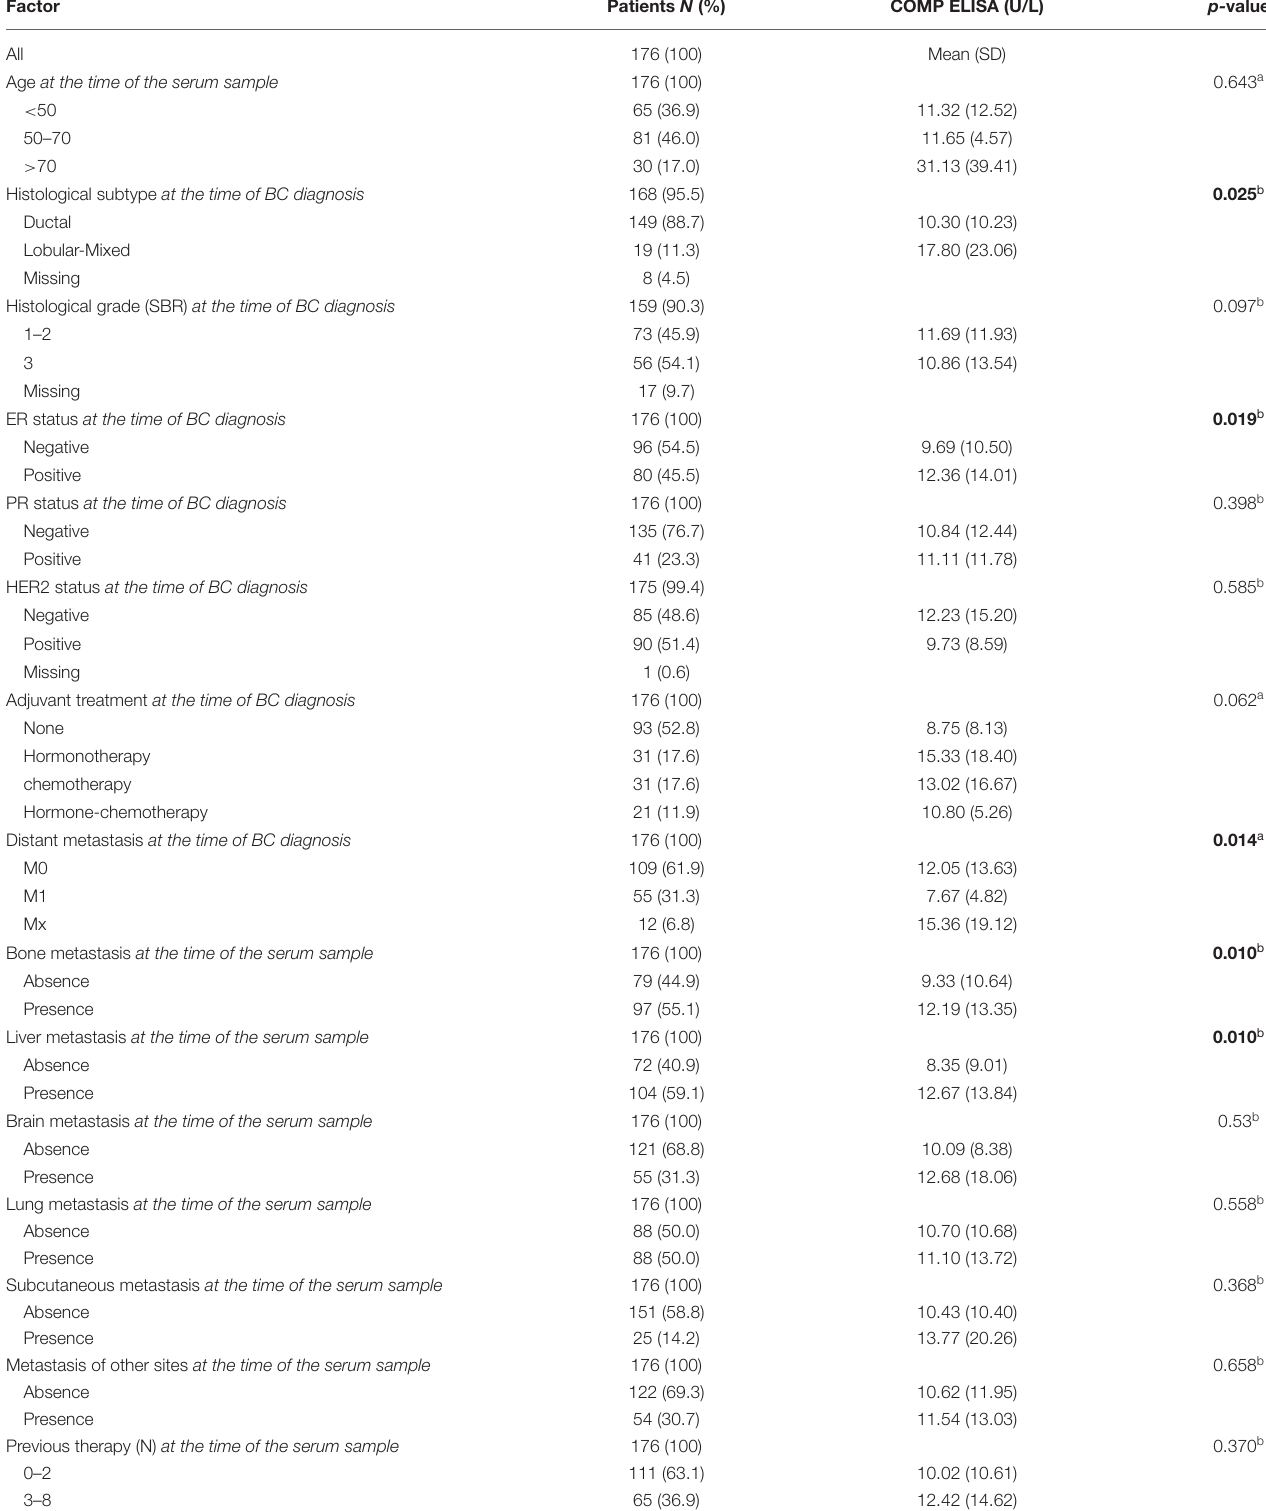
TABLE 2 | Association between COMP serum levels and clinical characteristics of the metastatic patients. Factor Patients N (%) COMP ELISA